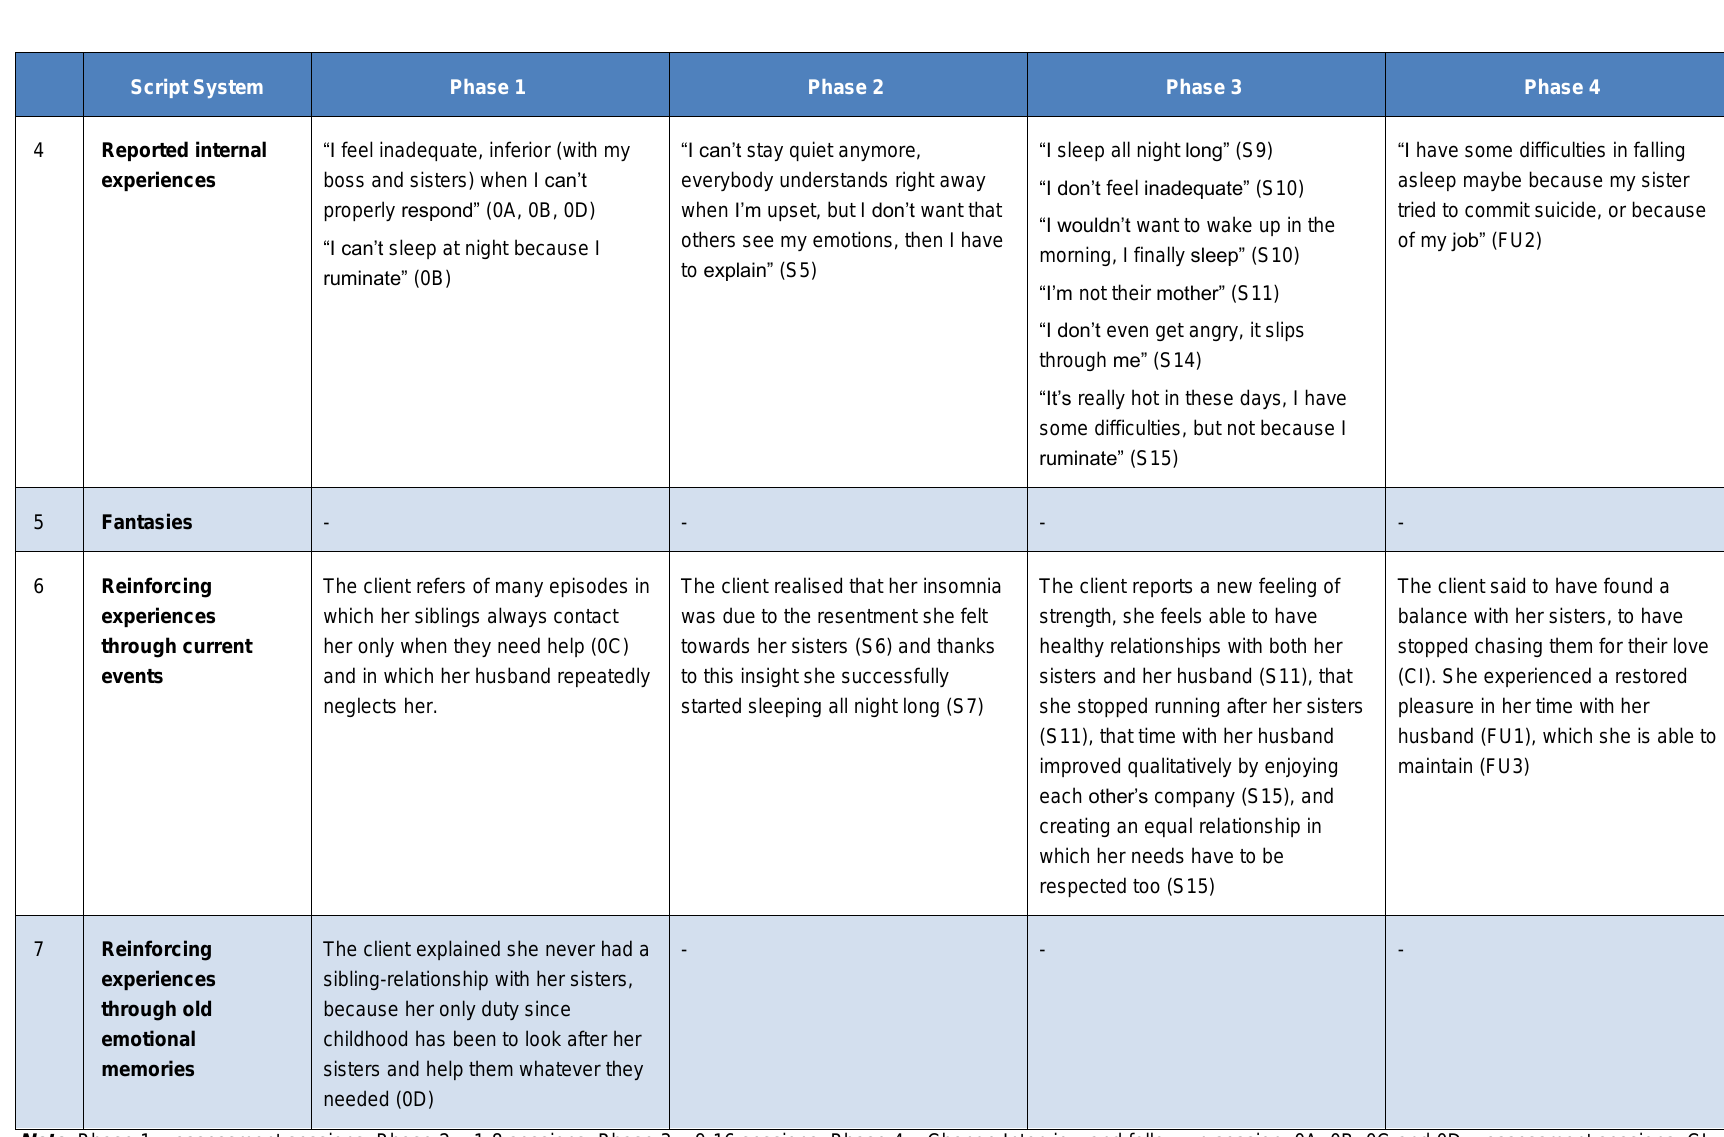
Table 3: How Margherita’s Script System changed from Phase 1 to Phase